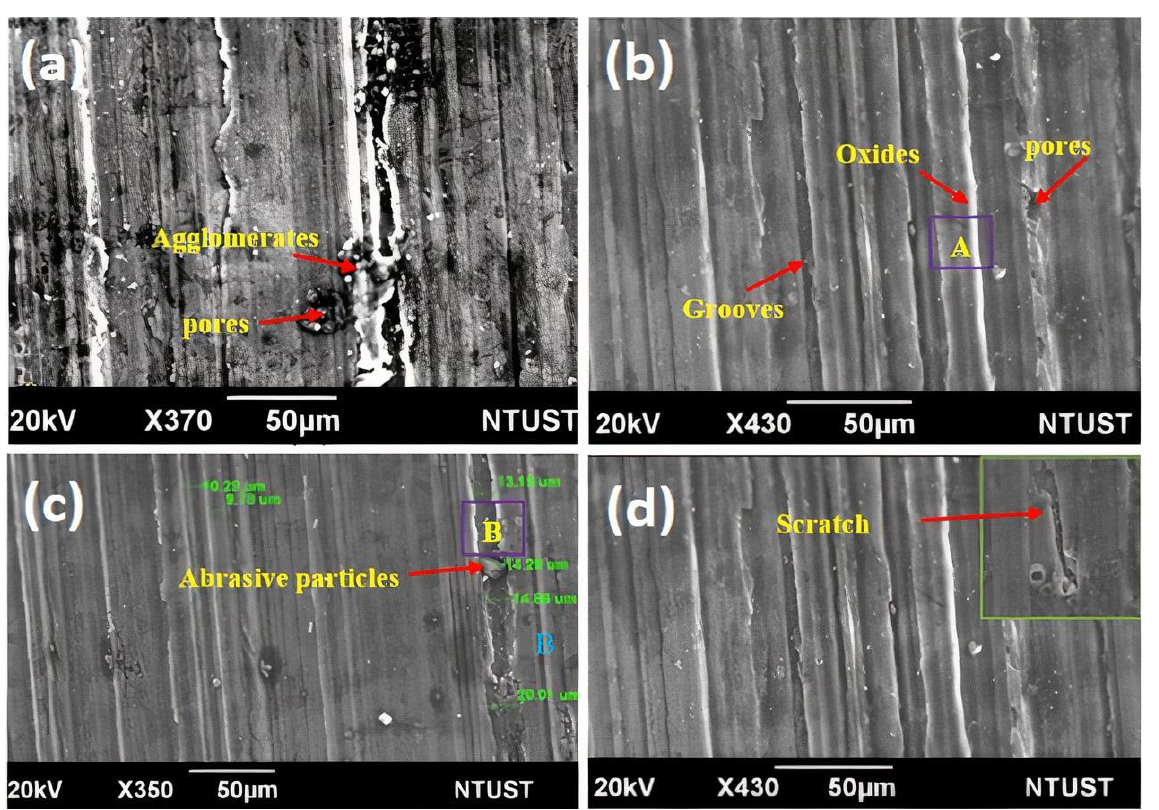
Figure 8. Pictorial observations of external worn-out structure of AZ31-based CNT-reinforced composites through SEM composed with CNTs wt.% of ( a ) 1.0, ( b ) 0.5, ( c ) 0.1, and ( d ) 0, in dry circumstances [36].